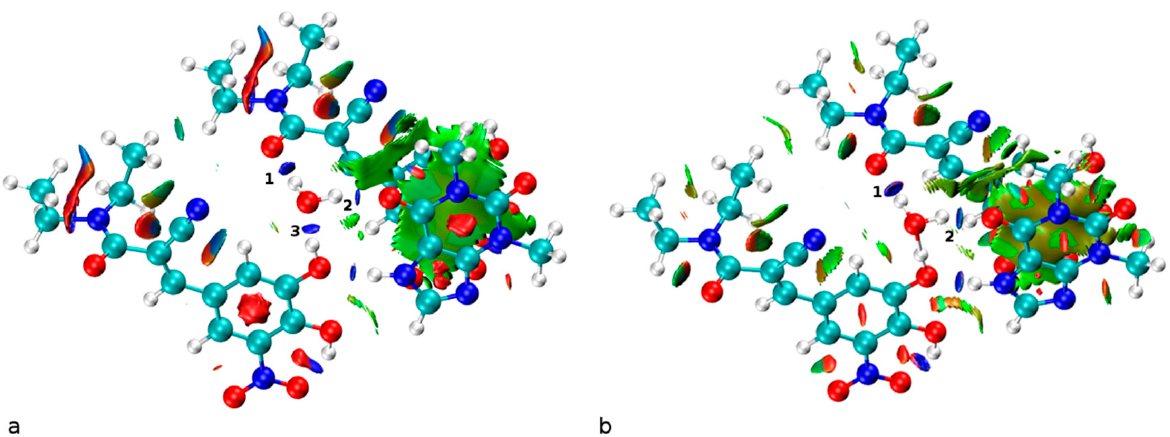
Figure 9. NCI plots of ENT-THP-water cocrystal using ( a ) the crystal structure and the promolecular density and ( b ) the QM/MM structure with the computed density. The numbers denote non-covalent hydrogen-oxygen interactions with water.